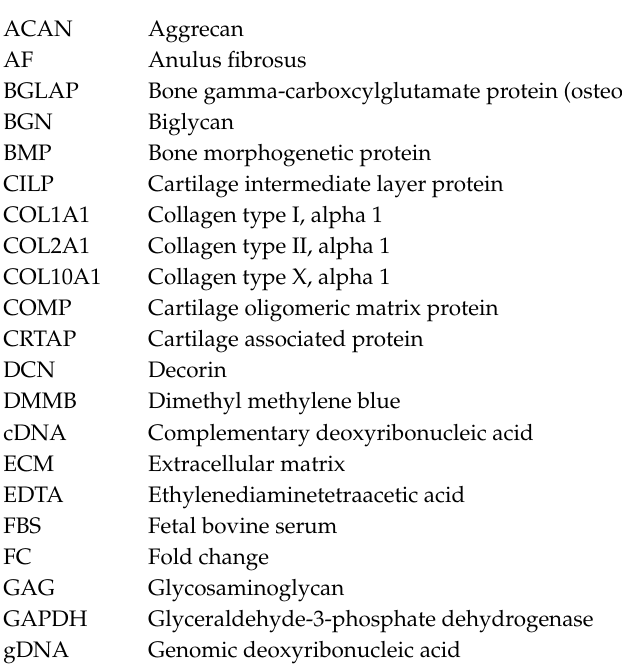
s1. Table S1: Di ff erentially regulated genes in native AF tissue of IVDs with mild and severe degeneration grades; Table S2: Di ff erentially regulated genes in monolayer cultivated cells derived from AF tissue of IVDs with mild and severe degeneration